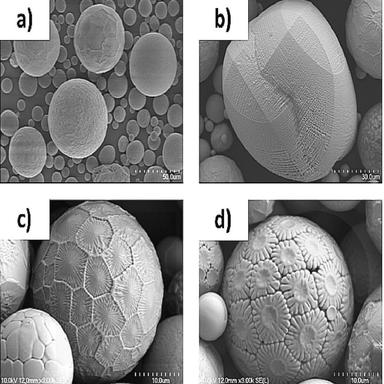
SEM images of the separated larger particles. a) a general view of particles, b) non-spheroidized particles, and c & d) flower-type spherical particles.